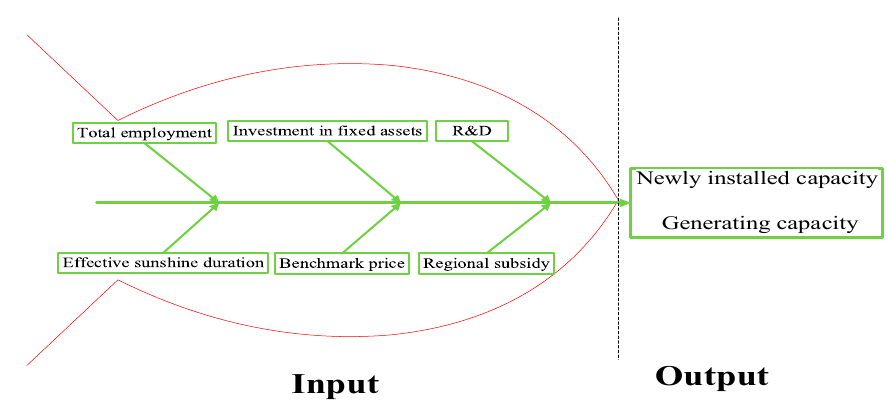
Figure 4. Input and output indicators of the DEA model (the green arrows stand for “input”).